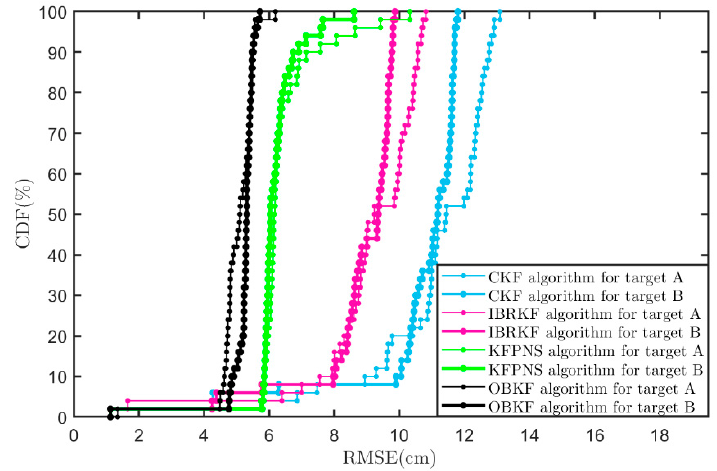
Figure 12. CDFs of RMSE for various algorithms in an indoor scene.